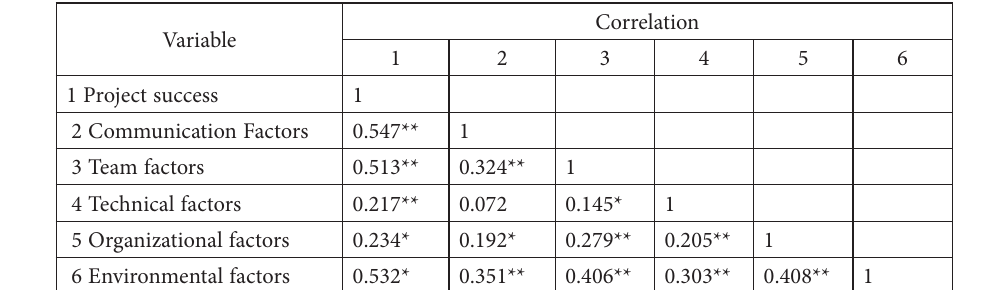
Table 5. Correlation